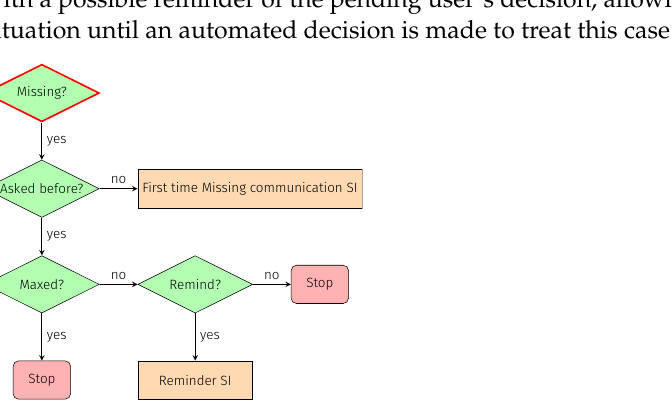
Figure 3. Missing communication.